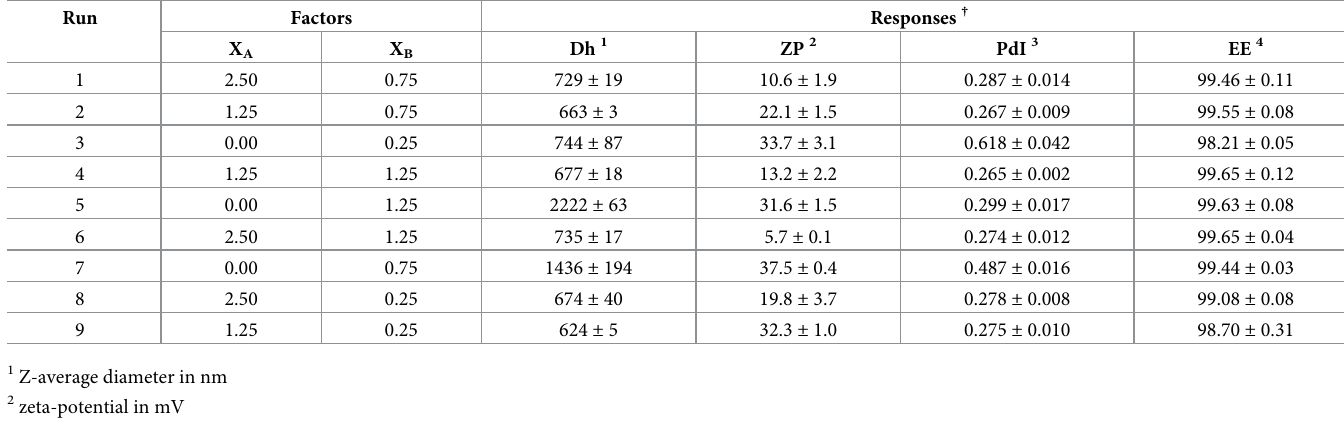
Table 2. Central composite factorial design for two factors and four responses.